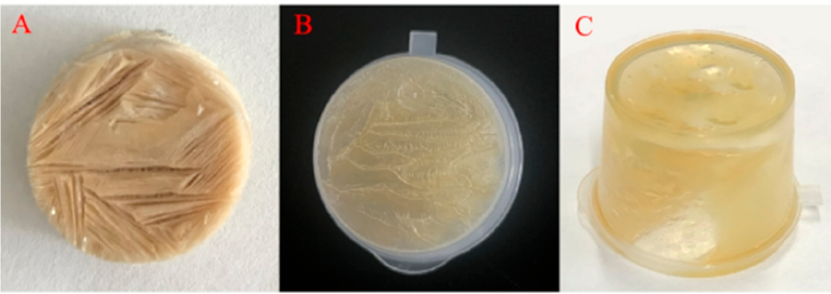
Figure 2. Appearance of freeze-dried products prepared with COBET containing 1.0% ( A ), 0.1% CS ( B ) and without CS ( C ).